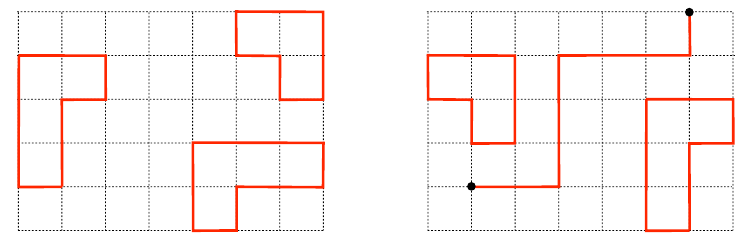
Figure 1 . Left : partition function of an O ( N ) loop model sums up weights of loop con(cid:12)gurations living on a lattice. E.g. the shown con(cid:12)guration of three loops has weight: N 3 K 8+10+10 , where 8, 10, 10 are the loop lengths. Right : typical contribution to the defect-defect correlator in the loop model, which corresponds to the spin-spin correlator of the spin